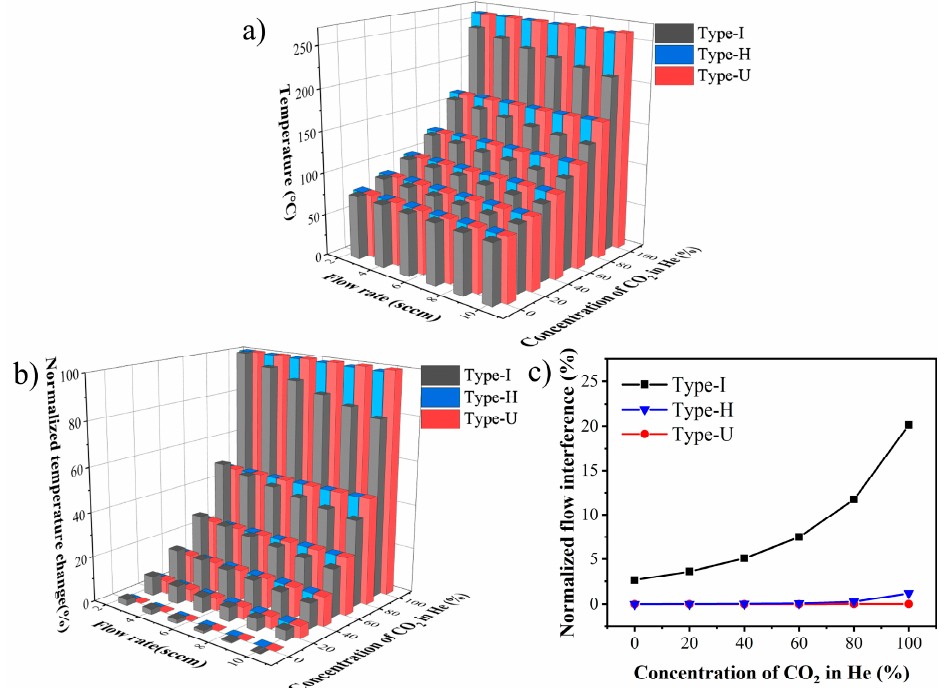
Figure 4. The simulation results of changes in gas flow rate and concentration simultaneously. ( a ) The temperature of the hot film, ( b ) the normalized temperature, ( c ) the normalized flow interfer- ence under different gas conditions. Table 2. Simulation results: the normalized temperature change of the hot film under multiple con- centrations.